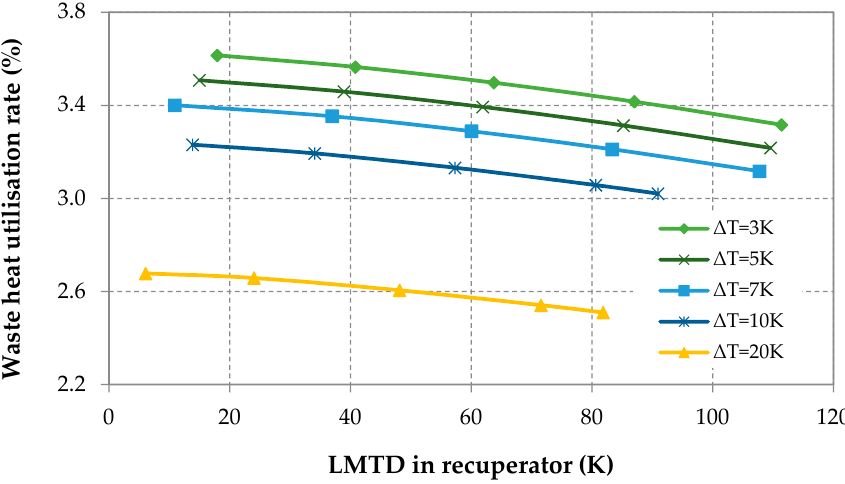
Figure 10. Relationship between the LMTD and waste heat utilization rate for varied temperature differences between CO 2 and the exhaust gases at the inlet and outlet of the heat exchanger. The CO 2 mass flow was not the assumed value. CO 2 mass flow was calculated as the